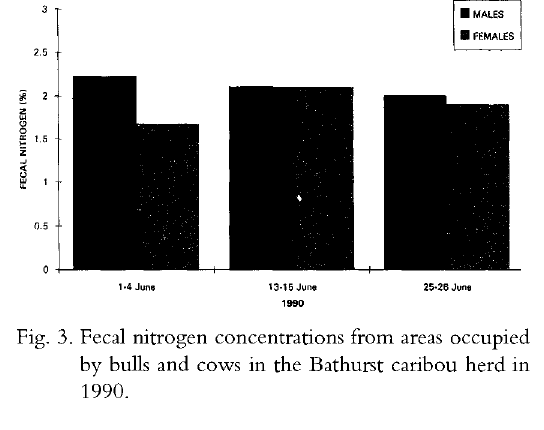
indexed by the w o lf sighting rate, averaged only 22% of densities on caribou winter and spring rang es, i.e., in March and April. This trend was the same for all 4 herds (Table 3). On the Beverly herd's calving ground in 1993 we saw 16 wolves in 64.2 h of flying (24.9 wolves/100 h) and w o lf